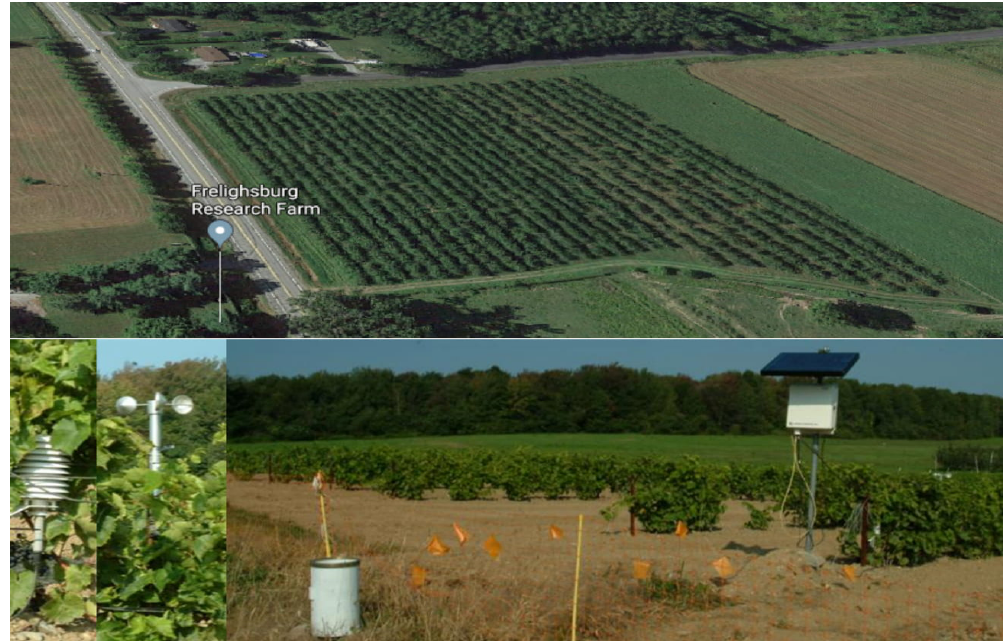
Figure 1. The experimental farm (top) and the weather station (bottom) used to monitor climate variables at the grape canopy level from 2000 to